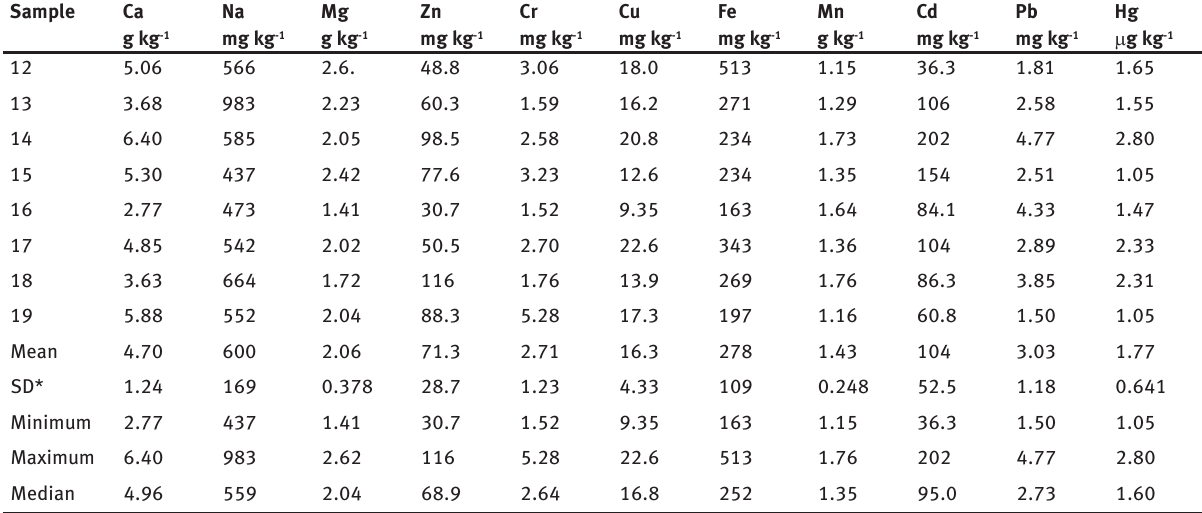
Table 5: Elemental content in analyzed green tea samples expressed as dry mass of the samples (mean of three measurements)